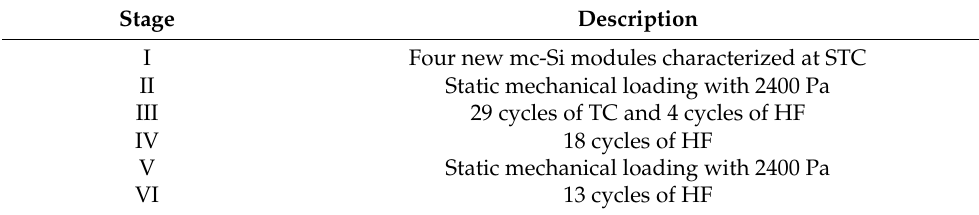
Table 1. Description of the experiment stages.